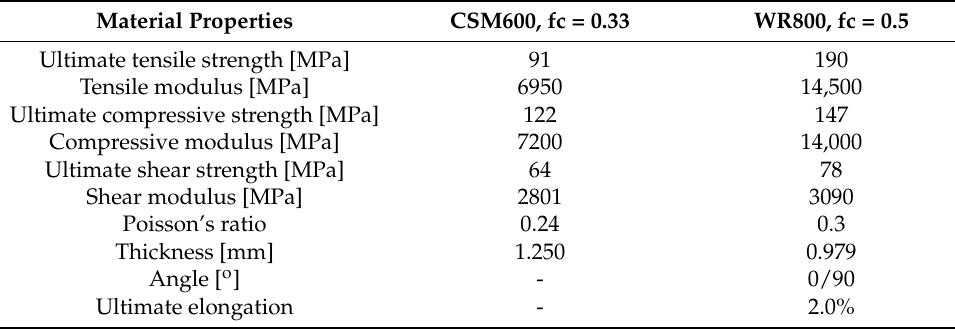
Figure 2. Composite plates with ( a ) 10 mm and ( b ) 12 mm thickness. Table 1. Material properties of different composite materials [2].